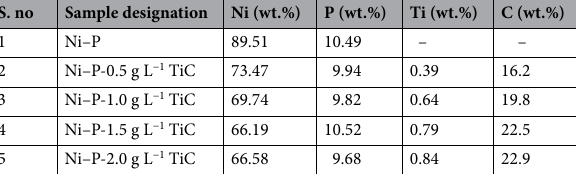
Table 3. EDS quantitative analysis of Ni–P and Ni–P-TiC composite coatings.